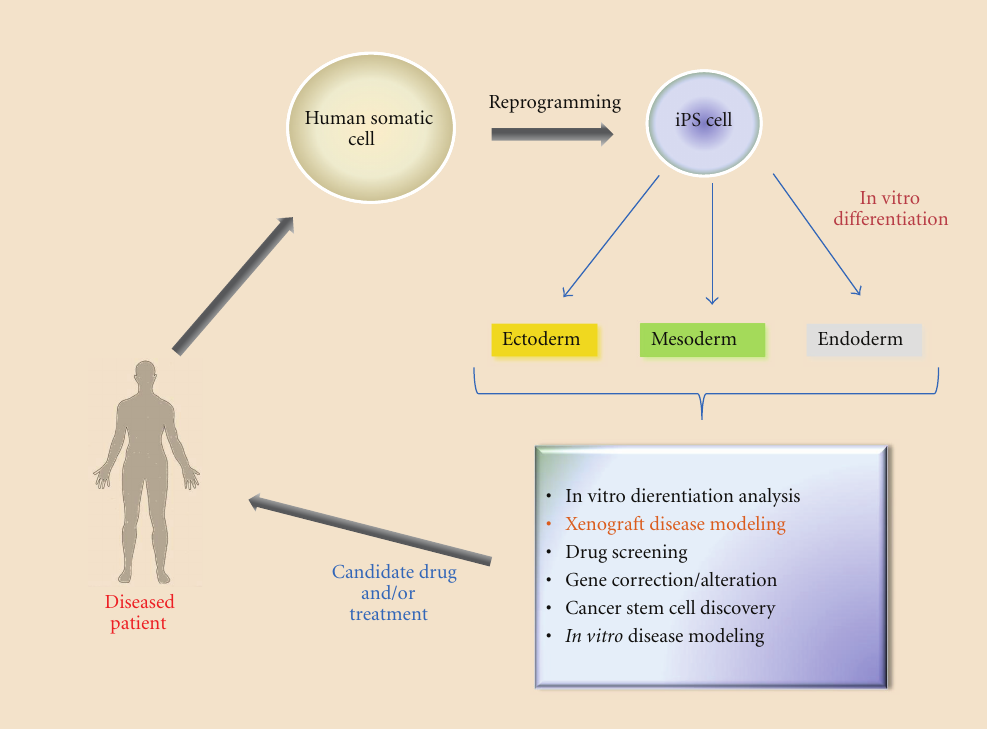
Figure 3: Human induced pluripotent stem cells applications for human disease mouse